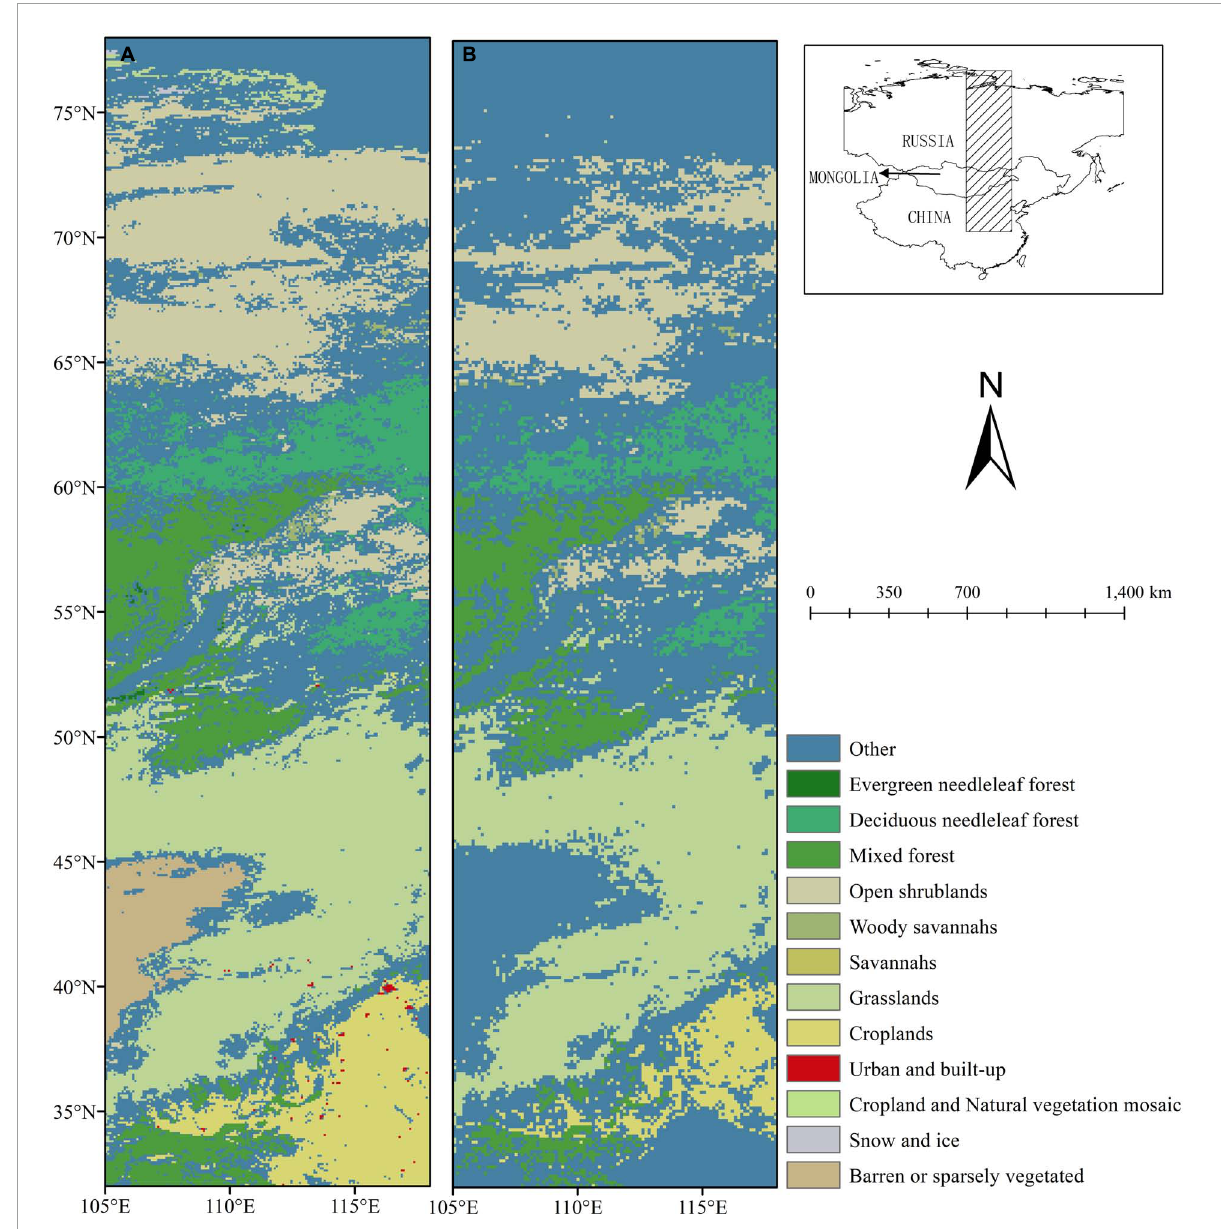
FIGURE1 Land cover in the North–South Transect of Northeast Asia (NSTNEA) region: (A) original stable land cover, (B) redefined vegetation types.